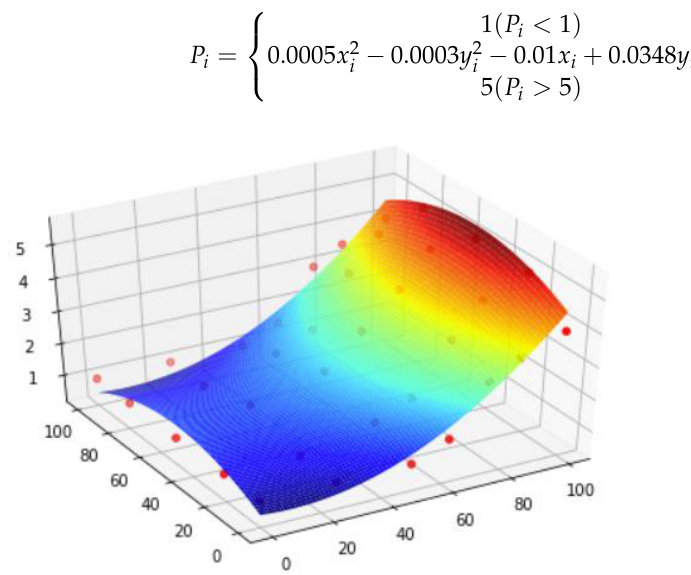
Figure 3. Graph of the coordinate regression equation. In Formula (2), x i and y i are, respectively, the abscissa and the ordinate of the end point of the i pass.